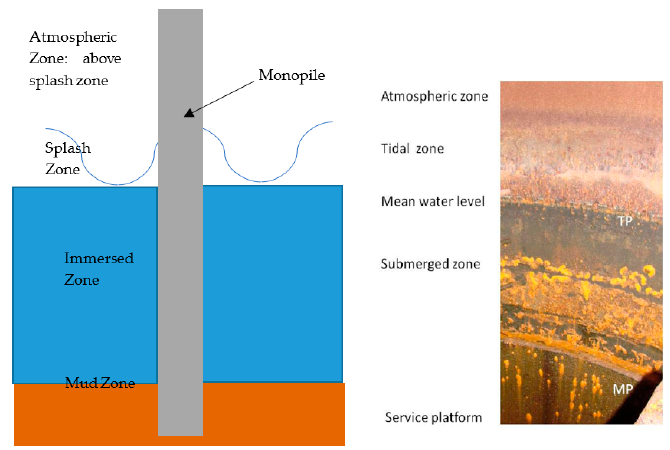
Figure 1. ( a ) different corrosion levels inside the monopole. ( b ) corroded regions inside monopiles [13].